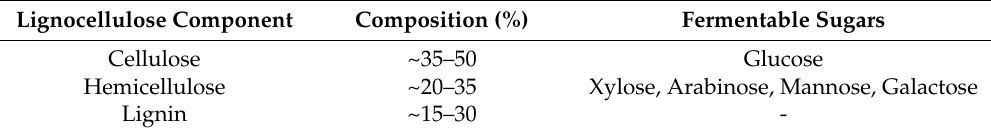
Table 1. Components of plant lignocellulosic biomass and their typical